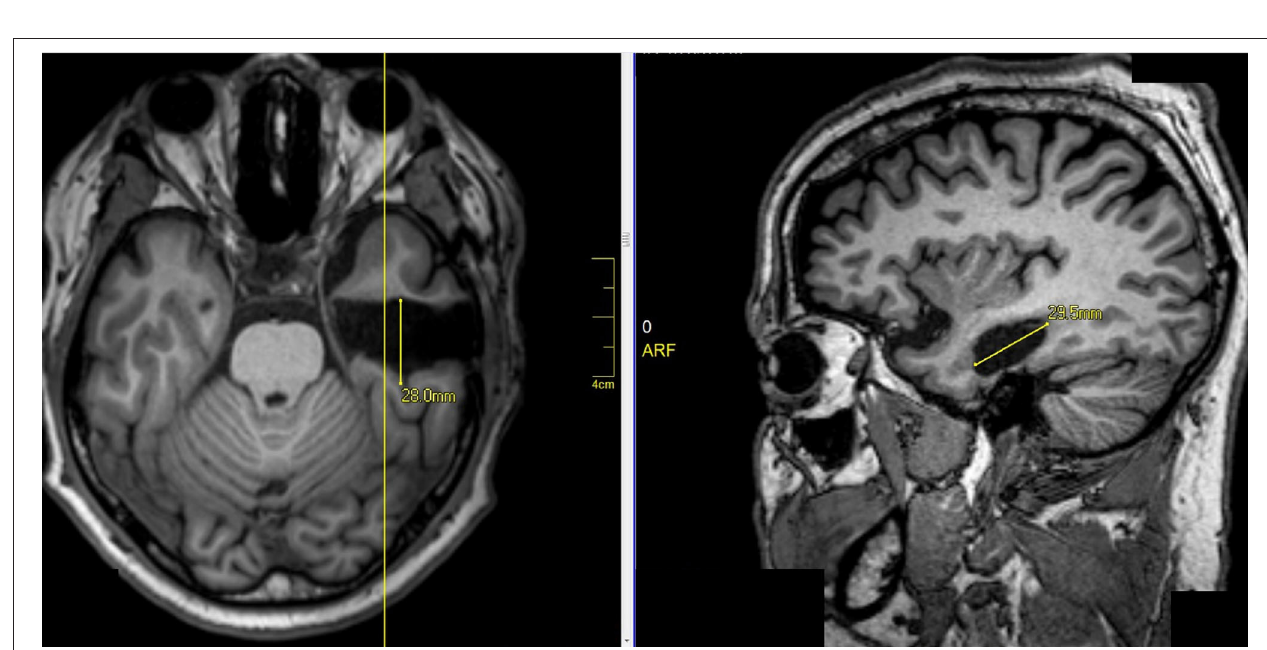
FIGURE 2 | Selective amygdalohippocampectomy (SAH) via subtemporal approach, with preservation of the pole.